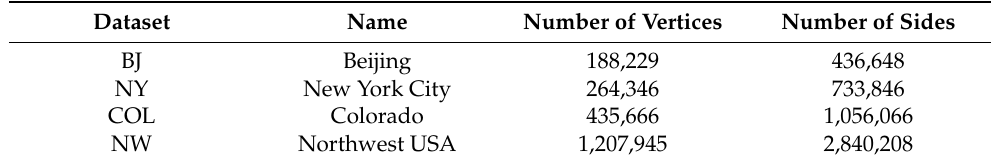
Table 2. Experimental software and hardware configuration